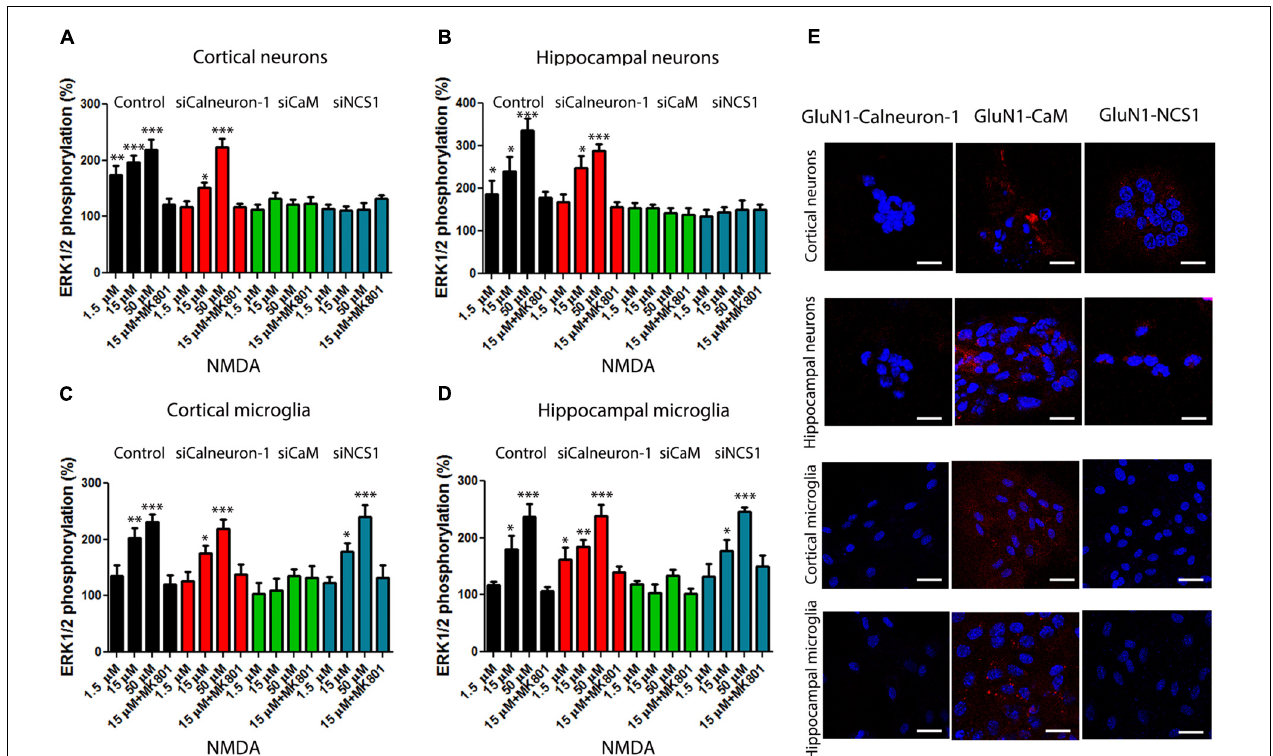
FIGURE 3 | NMDAR-mediated signaling in primary cultures of neurons and microglia from cortex and hippocampus. (A–D) MAPK phosphorylation levels were analyzed after stimulating with NMDA (at the indicated concentrations) primary cultures of cortical (A) , or hippocampal neurons (B) , or of cortex (C) or hippocampal microglia (D) . Experiments were performed in cells transfected or not (black bars) with siRNA to silence calneuron-1 (red bars), CaM (green bars), or NCS1 (blue bars) expression. Different concentrations of NMDA (from 50 to 1.5 µ M) were used to activate the receptor and the NMDAR antagonist, MK-801 (10 µ M), was used for specificity checking. Labels in X axis are equal in bar graphs of panels (A–D) . Values are the mean ± SEM ( n = 12). Significant differences over basal condition were calculated by one-way ANOVA and Bonferroni post hoc test ( ∗ p < 0.05, ∗∗ p < 0.01, and ∗∗∗ p < 0.005). (E) Proximity ligation assays (PLAs) were performed in primary cultures of mice cortex or hippocampus and primary antibodies specific for NMDAR and for calneuron-1, CaM, or NCS1. Confocal microscopy images are shown (superimposed sections) in which heteromers appear as red clusters (in neurons or microglia). Scale bars = 10 µ m (neurons) and 20 µ m (microglia). In all cases, cell nuclei were stained with Hoechst